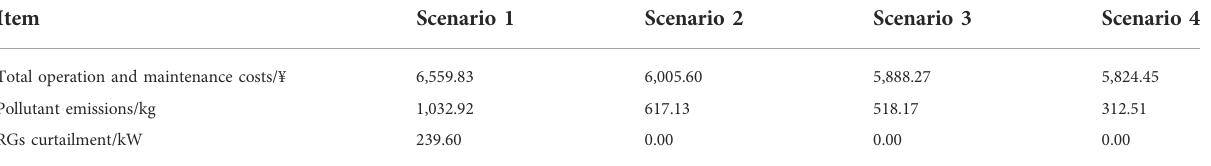
TABLE 2 Comparison of economy under different scenarios of demand